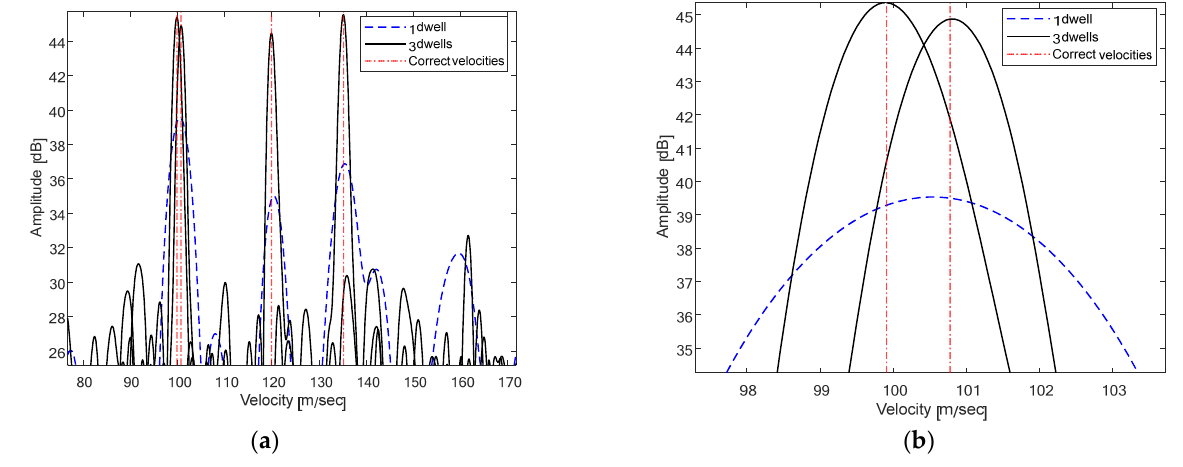
Figure 8. CMDP simulation results. ( a ) Shows achieving both higher velocity estimation and improved SNR. ( b ) Shows that an additional real target has been detected as a result of the super-resolution.